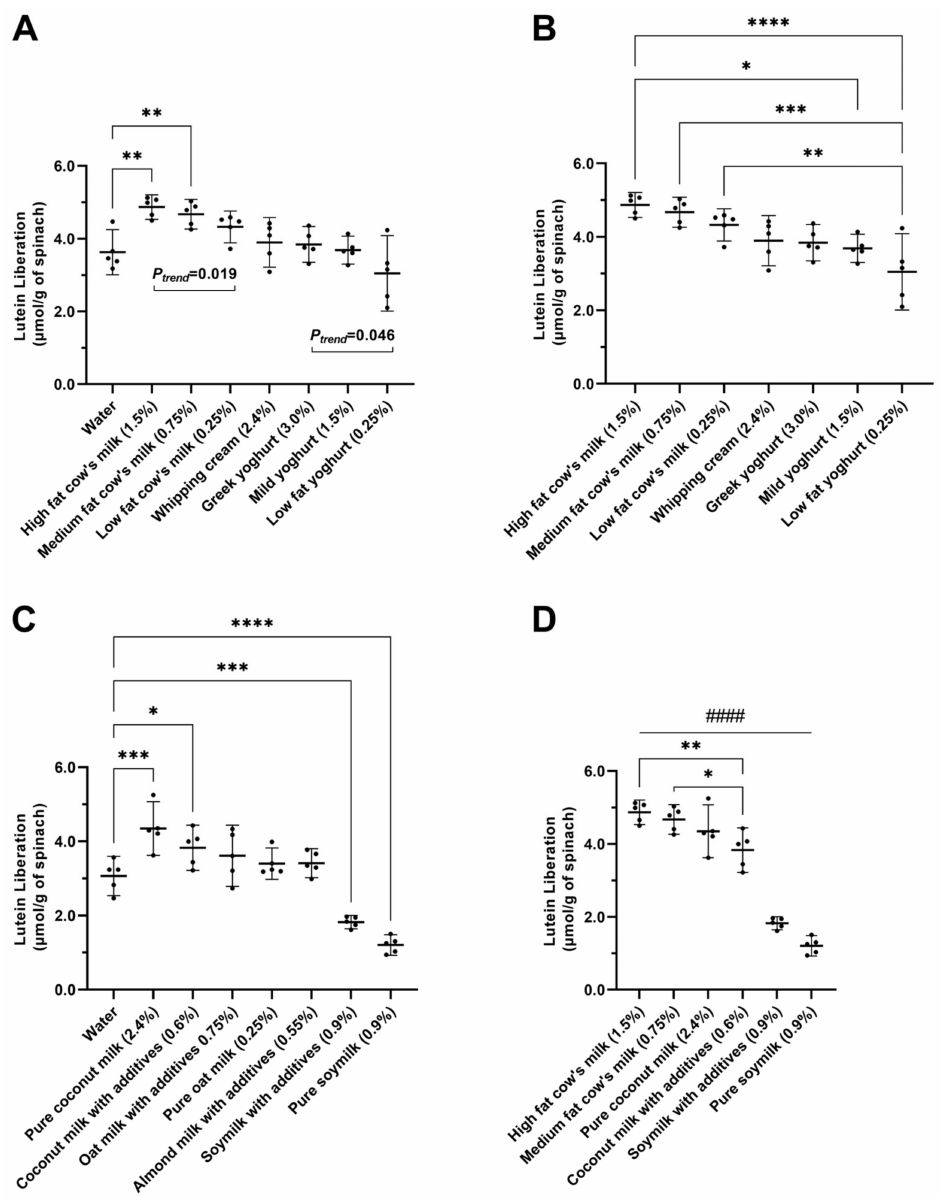
Figure 1. Levels of liberated lutein from spinach smoothies made with dairy or plant-based liquid components. Final fat concentrations in the resulting smoothies are listed in brackets. Data are presented in µ mol of liberated lutein after in vitro digestion per gram of spinach used in smoothie. n = 5 for all groups. ( A ) Multiple comparisons of lutein liberation between smoothies with any dairy liquid and water are presented. P for trend ( P trend ) from linear regression amongst the milk or yogurt products is shown. ( B ) Multiple comparisons of lutein liberation amongst the smoothies made with dairy products (only the notable significances are shown). ( C ) Multiple comparisons of lutein liberation between smoothies with any plant-based liquids and water are presented. ( D ) Multiple comparisons of lutein liberation between the improvers and reducers * p < 0.05, ** p < 0.01, *** p < 0.001, and **** p < 0.0001 between two types of liquids. #### p < 0.0001 between any improvers and any reducers in Figure 1D. Error bars represent means with 95%